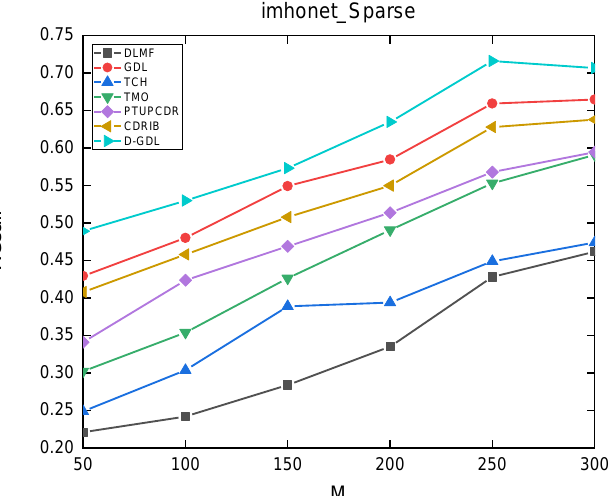
Figure A11. Performance Results of the proposed method against the comparative approaches based on Recall for the Amazon book dataset.